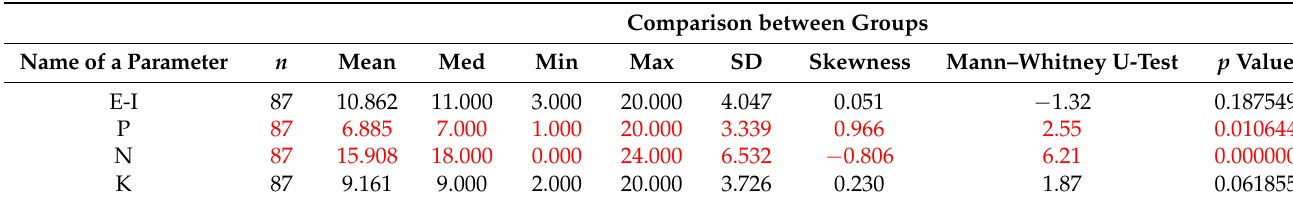
Table 6. Results of Eysenck test—comparison between groups (statistically significant results marked with red colour).